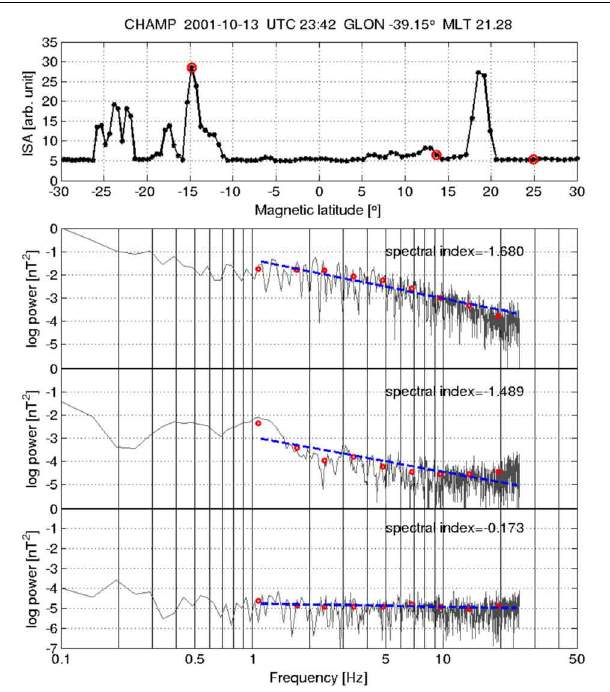
FIGURE 6 | Spectral properties of three events marked by red circles in the top frame. The spectra are approximated by a power law (blue dashed line). The top spectrum is from a large event, in the middle an example of a small-amplitude event is shown, where the high-frequency part is contaminated by noise. The bottom panel represents a noise spectrum.